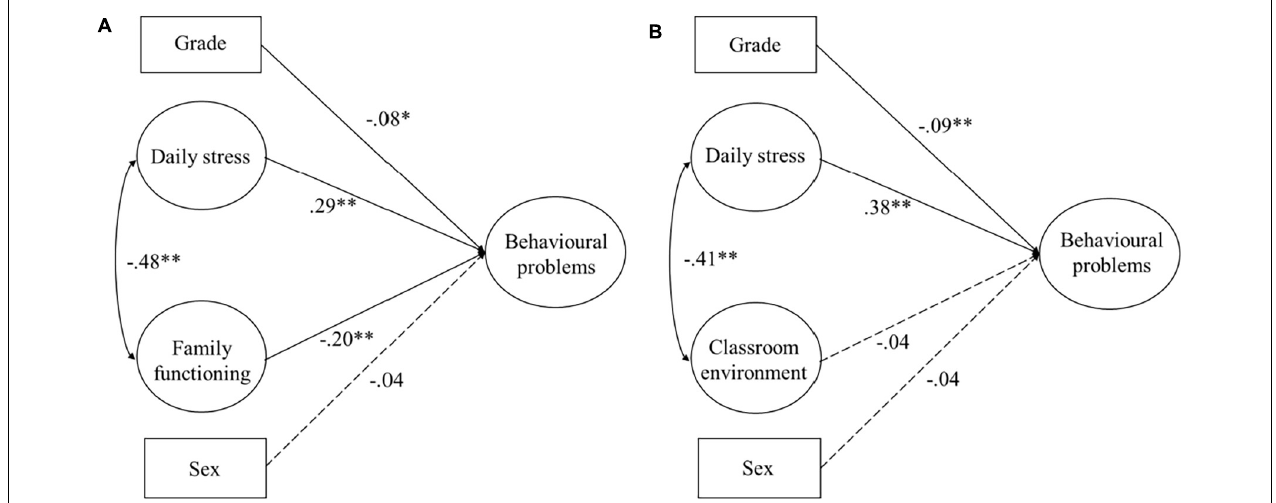
FIGURE 1 | Structural models without a latent variable interaction. (A) Model 0: Main effects of daily stress and family functioning; (B) Model 0: Main effects of daily stress and classroom environment. * p < 0.05, ** p <